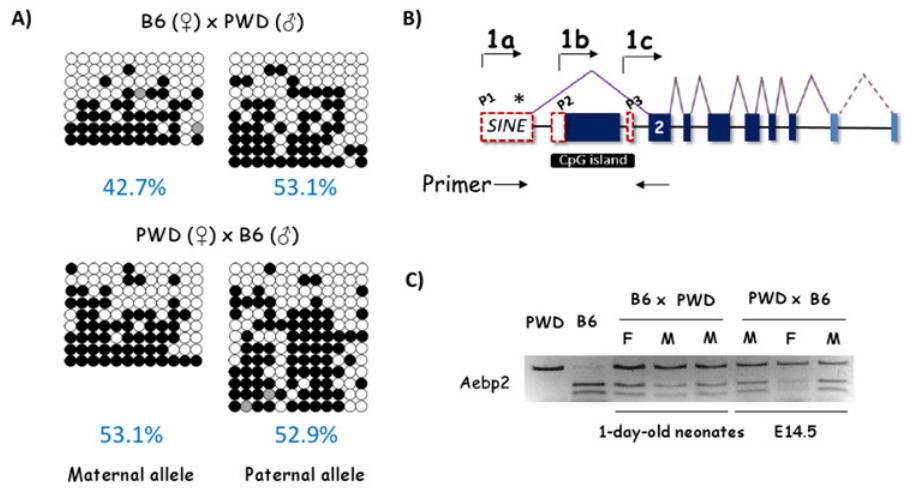
Fig 3. Non-allelic, partial DNA methylation pattern of the P1 promoter. (A) The DNA methylation levels of the P1 promoter were analyzed using one set of F1 hybrid offspring derived from the reciprocal crosses between C57BL/6J and PWD/PhJ. Individual sequencing reads were separated based on the parental origin. White and black circles represent unmethylated and methylated CpG dinucleotides, respectively. Gray circles indicate the CpG dinucleotides with unknown methylated status. (B) RT-PCR scheme for imprinting test. Two primers targeting the P1-driven transcript were shown as arrows underneath the exon structure of mouse Aebp2 . The asterisk ( * ) inside Exon1a indicates one sequence polymorphism between C57BL/6J and PWD/PhJ, which was used for differentiating two alleles by HpyCH 4III restriction enzyme digestion of the RT-PCR product. (C) Biallelic expression of the P1-driven transcript. Two sets of RT-PCR products derived from E14.5 embryos (lanes six-eight) and one-day-old pups (lanes three-five) were digested with the restriction enzyme to test their allelic origin. The digestion patterns were also compared with those of two parental strains (lanes one and